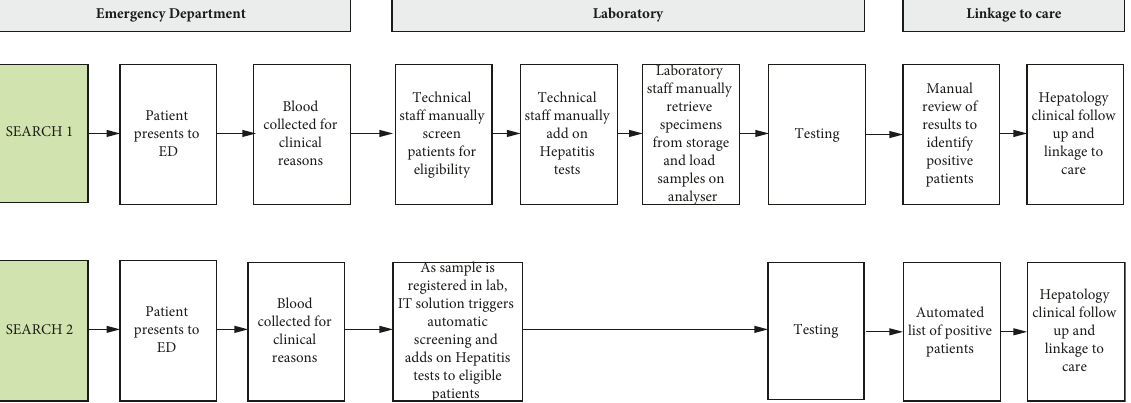
Figure 1: Operational flow of SEARCH 1 compared to SEARCH 2.